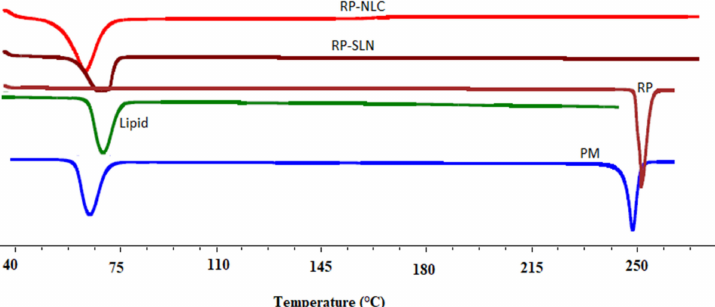
Figure 3. DSC thermogram of pure drug (RP), pure lipid (Lipid), physical mixture of drug and lipid (PM), lyophilized optimized RP-SLN formulation (RP-SLN) and RP-NLC formulation (RP-NLC).